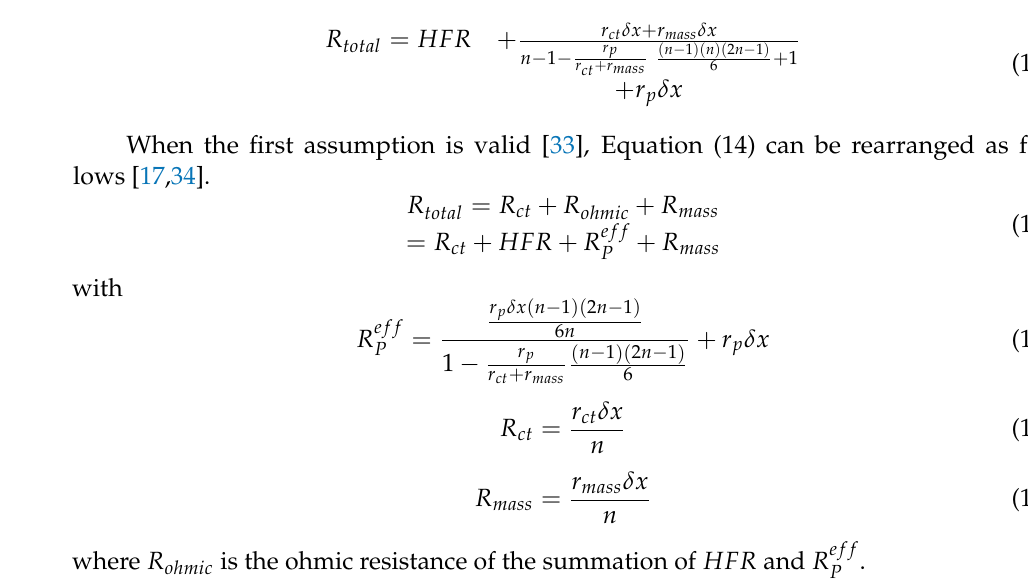
Figure 3. Equation (7) is simplified. Equation (11) can be used only if the k is large. On the other hand, the error in Equation (13) is less than 0.25% at 0.1 A/cm 2 , so this equation can be used regardless of the k. The general term can be derived by substituting Equation (13) into Equation